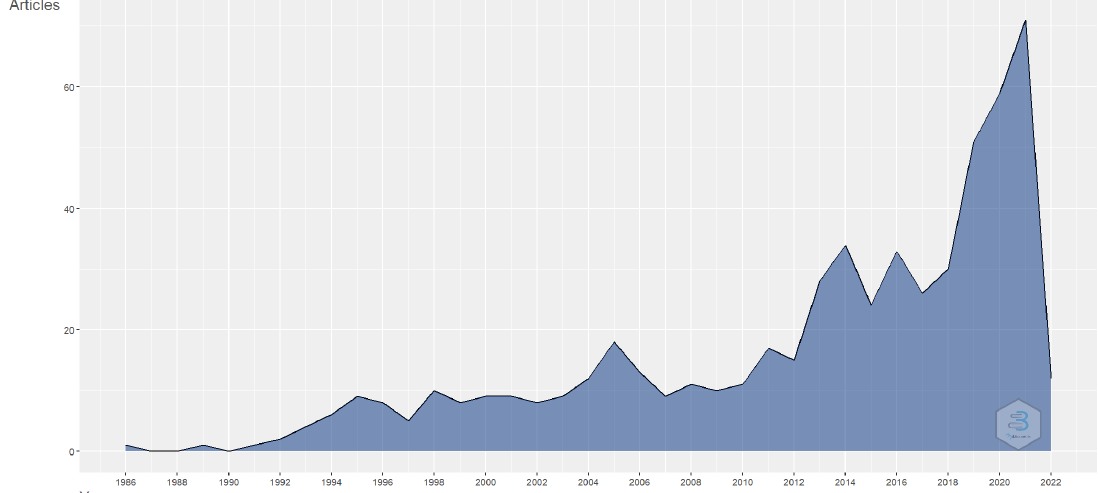
Figure 2. Annual scientific publications relating to transferrin/transferrin receptor-mediated drug delivery. Source: Authors’ elaboration using the Bibliometrix R-package .